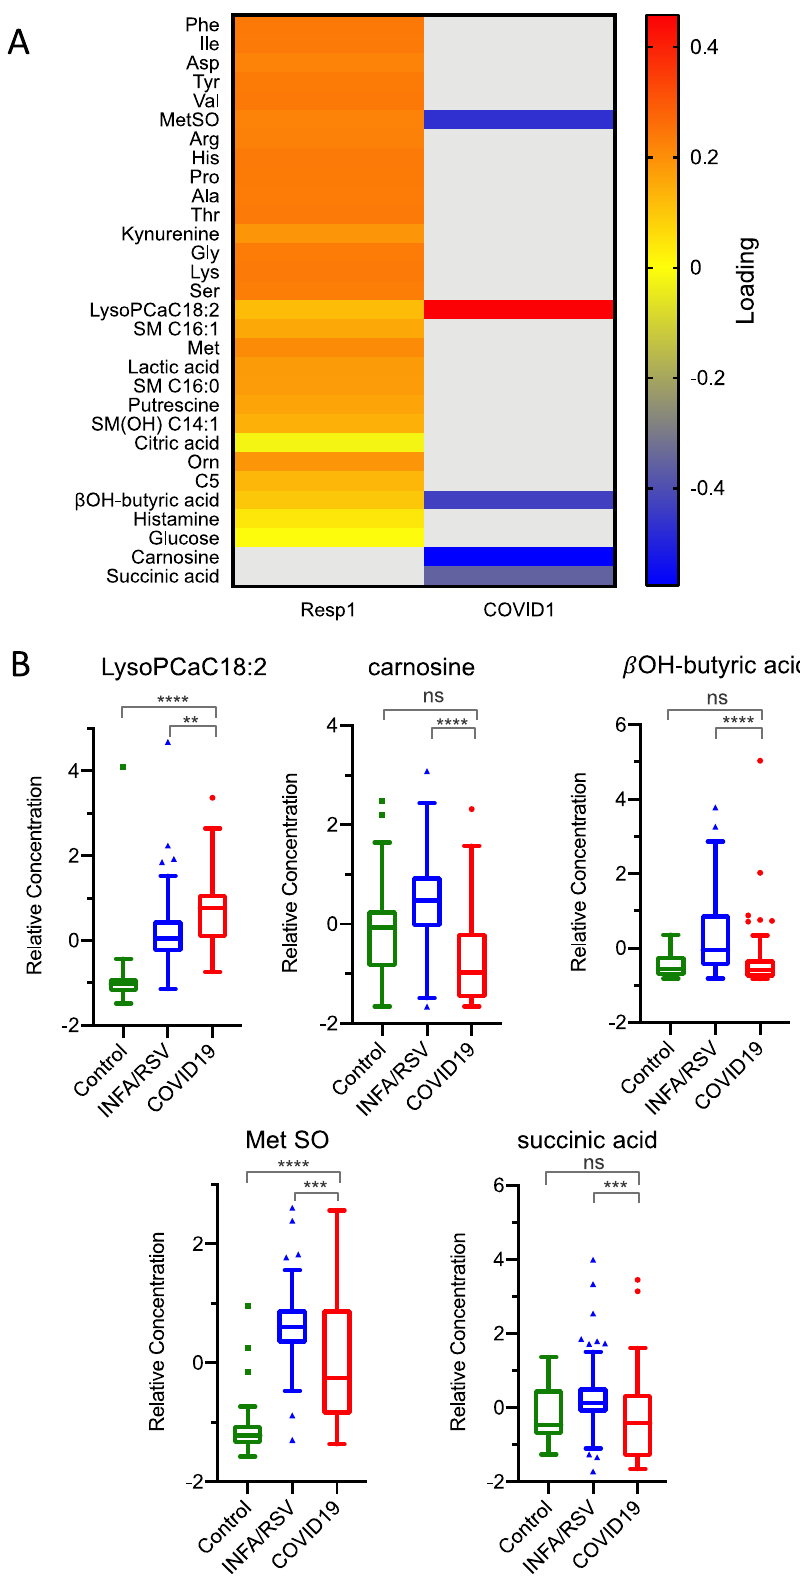
Figure 4. Feature selection from OPLS-DA models. ( A ) Metabolite loadings for respiratory infection and COVID19 models highlighting the most significant features. For the respiratory infection model, the heatmap denotes the relative association of each metabolite with respect to unaffected controls. For the COVID19 model, the heatmap denotes the relative association of each metabolite with respect to influenza A/RSV patient group. ( B ) Boxplots showing relative concentrations of significant metabolites from the COVID19 model are mean-centered at zero. For metabolites presented in ( B ), P < 0.0001 by Kruskal– Wallis test. Significance of between-group means by post hoc Dunn’s test is given in each